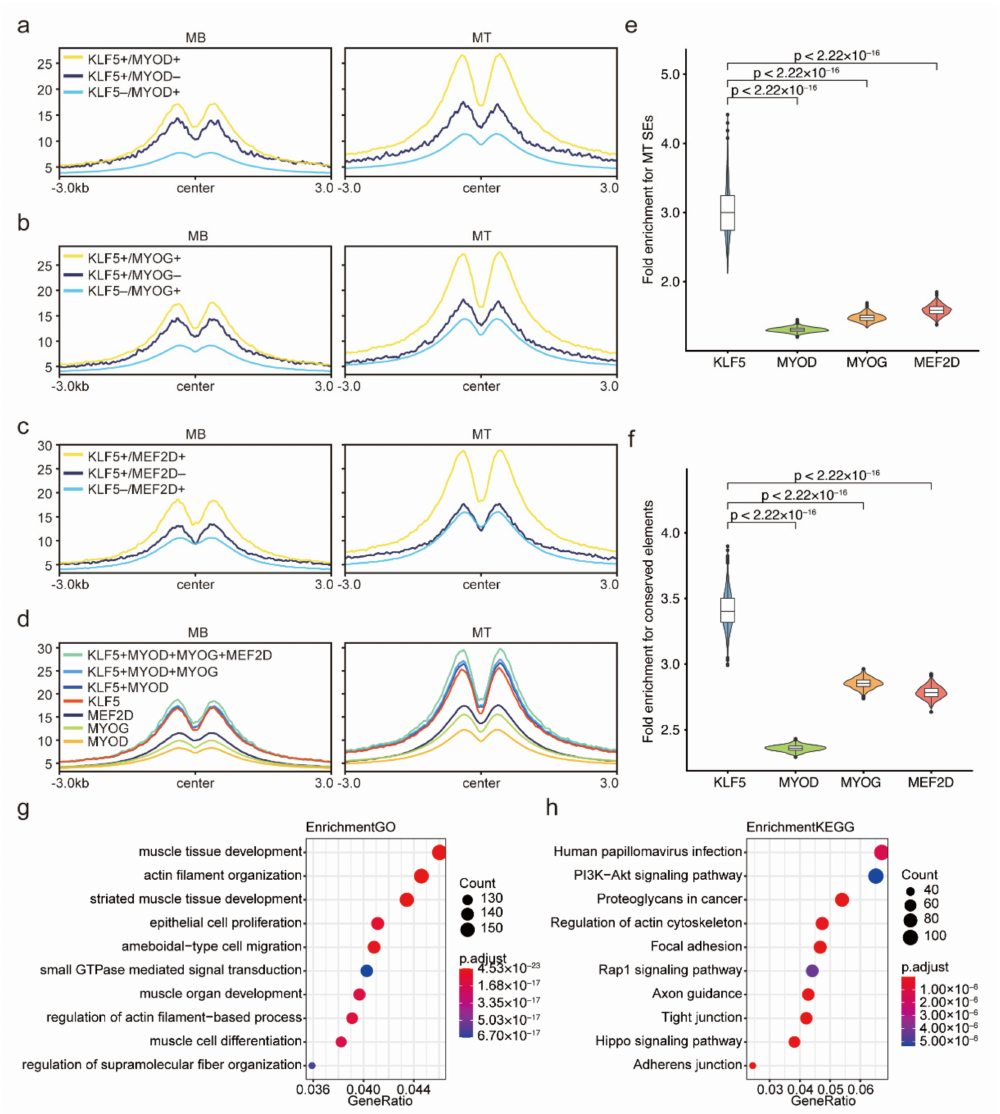
Figure 8. Enhancer properties of the KLF5-binding site for myogenesis. In C2C12 MBs and MTs, H3K27ac intensity of overlapping and nonoverlapping peaks in 3 groups: KLF5/MYOD ( a ), KLF5/MYOG ( b ), and KLF5/MEF2D ( c ). ( d ) In C2C12 MBs and MTs, H3K27ac intensity of 7 types of peaks: MYOD peaks, MYOG peaks, MEF2D peaks, KLF5 peaks, overlapping peaks of KLF5 and MYOD, overlapping peaks of KLF5, MYOD, and MYOG, overlapping peaks of KLF5, MYOD, MYOG, and MEF2D. Fold enrichments of KLF5-, MYOD-, MYOG-, and MEF2D-binding sites for SEs from C2C12 MTs ( e ) and mammalian-conserved elements from genomic evolutionary rate profiling (GERP) ( f ). Enriched GO terms ( g ) and KEGG pathways ( h ) for the KLF5-binding sites specific to C2C12 MTs relative to